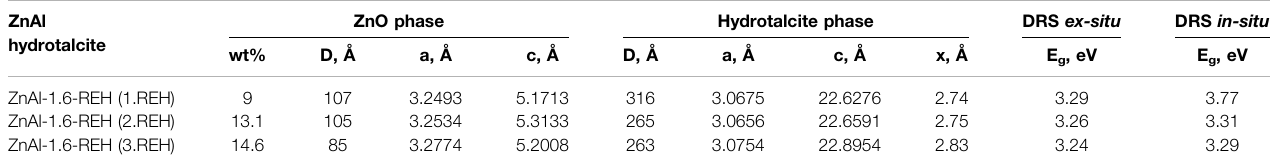
TABLE 2 | Crystallite size, lattice parameters, phase analysis and the shift of the edge of band from ex-situ and in-situ DRS measurement of three following circle of reconstruction of ZnAl-1.6-REH